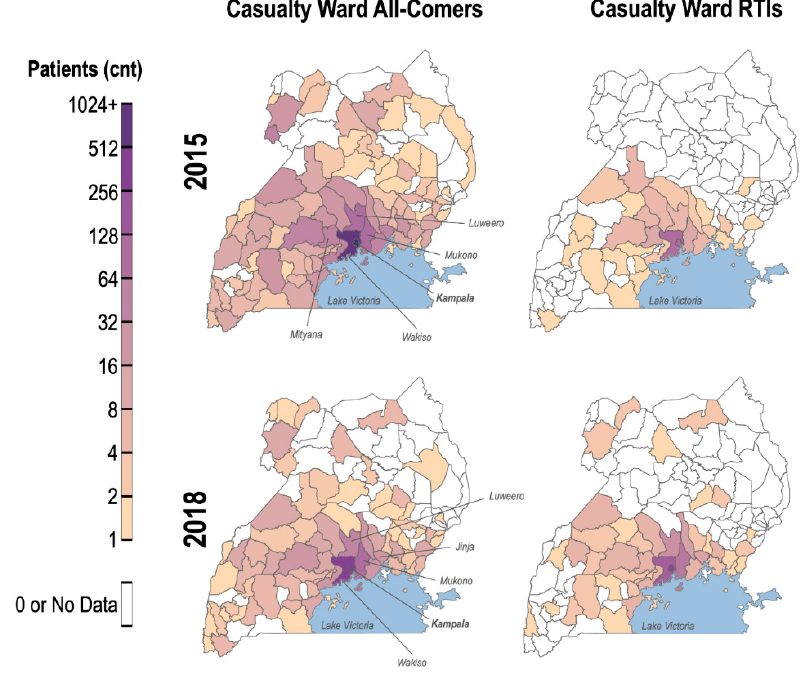
Figure 1. Heat map of RTIs by regions in Uganda.